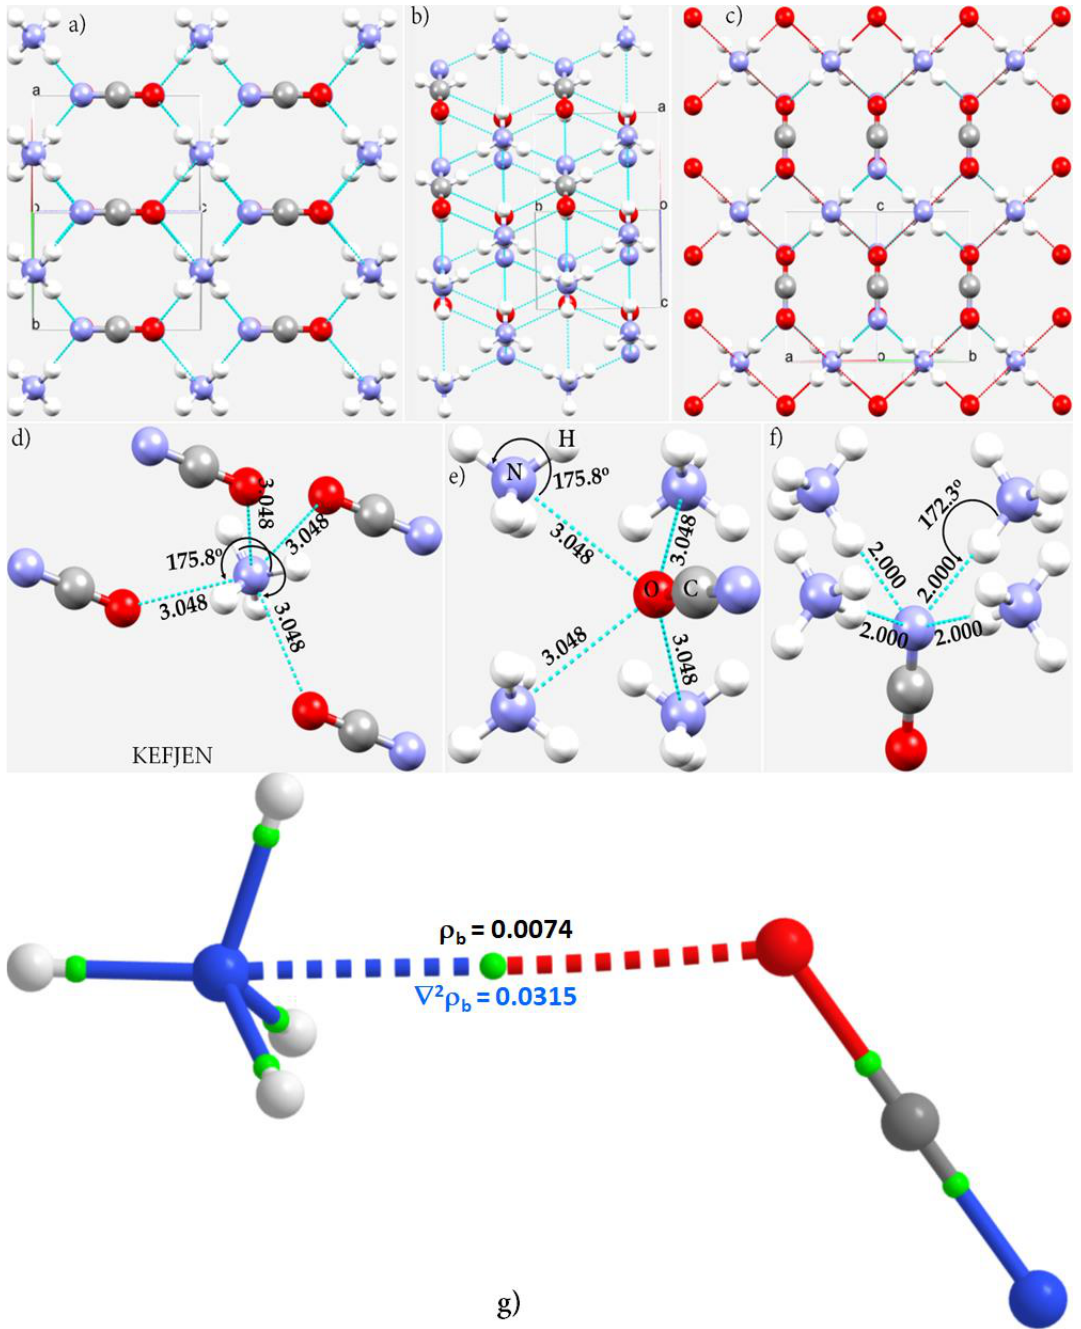
Figure 7. ( a – c ) Three different views of the ball-and-stick model of the 2 × 2 × 2 supercell structure of the crystal of ammonium cyanate, NH 4 CNO (CSD ref. KEFJEN); ( b – f ) The local nature of intermolecular bond distances and intermolecular bond angles between NH 4+ and CNO − , showing the coordination environment around ( d ) N in NH 4+ , ( e ) O in CNO − , and ( f ) N in CNO − . Bond distances and bond angles are in Å and degrees, respectively. Intermolecular contacts are colored in cyan and hanging contacts in c are colored in red. ( g ) MP2(FC)/def2-TZVPPD level QTAIM-based molecular graph for the ion-pair NH 4 CNO, obtained on its geometry as in the crystal; it shows the bond paths as sticks in atom color (N—blue; C—grey; O—red; H—white grey), bond critical points as tiny spheres between atomic basins in green, and values (in a.u. ) of charge density ρ b and the Laplacian of the charge density ∇ 2 ρ b at the N ··· O bond critical